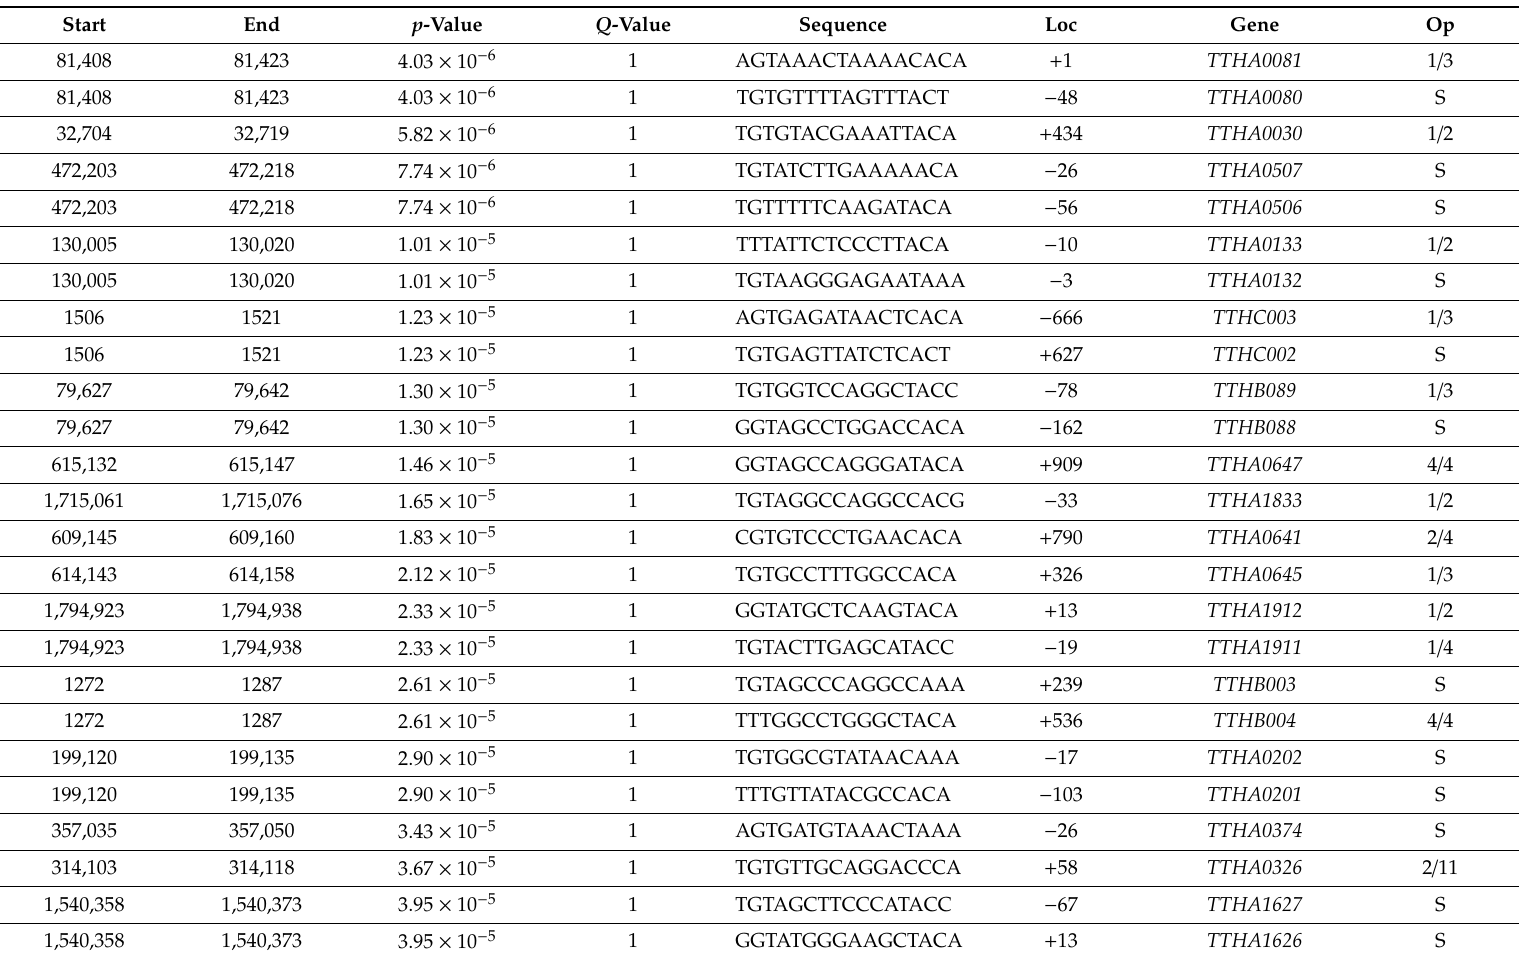
Table 2. TTHB099-consensus sequences mapped in the genome of T. thermophilus